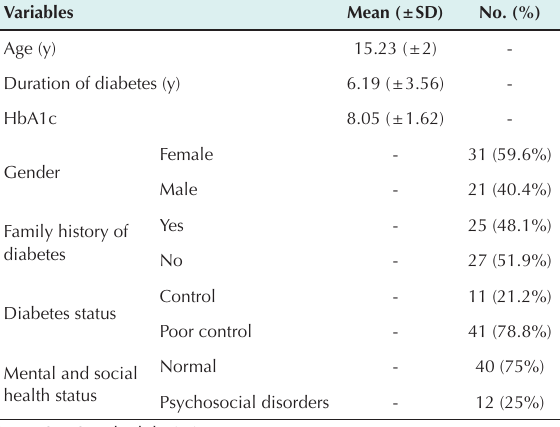
Table 1. Frequency of Participants’ Demographic and Disease-Related Variables Variables